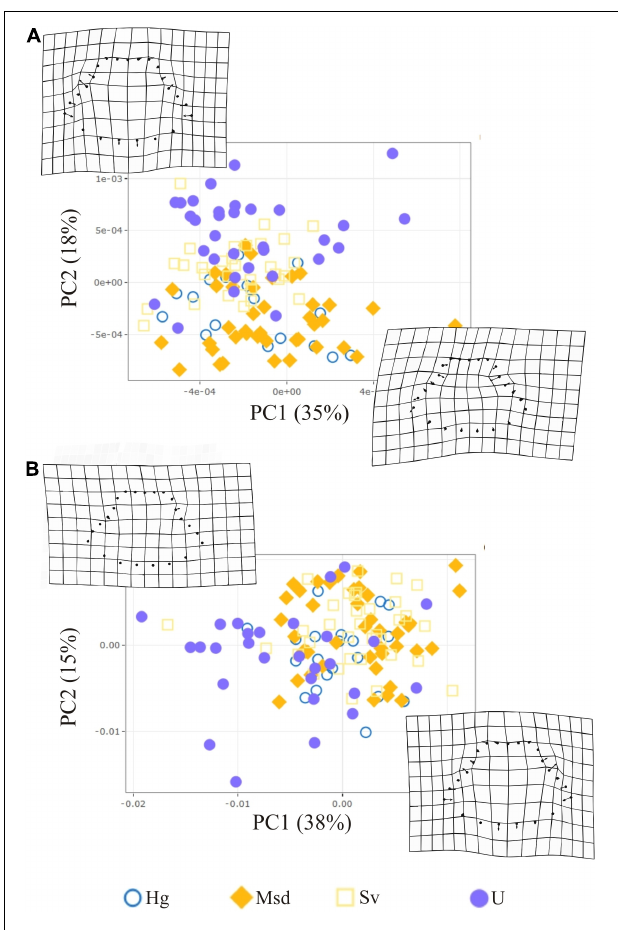
FIGURE 4 | PCA of thorax shape variation for T. dimidiata females (A) and males (B) . Landscape: Urban (U), Homegarden (Hg), Secondary vegetation (Sv), and Median subdeciduous tropical forest (Msd).